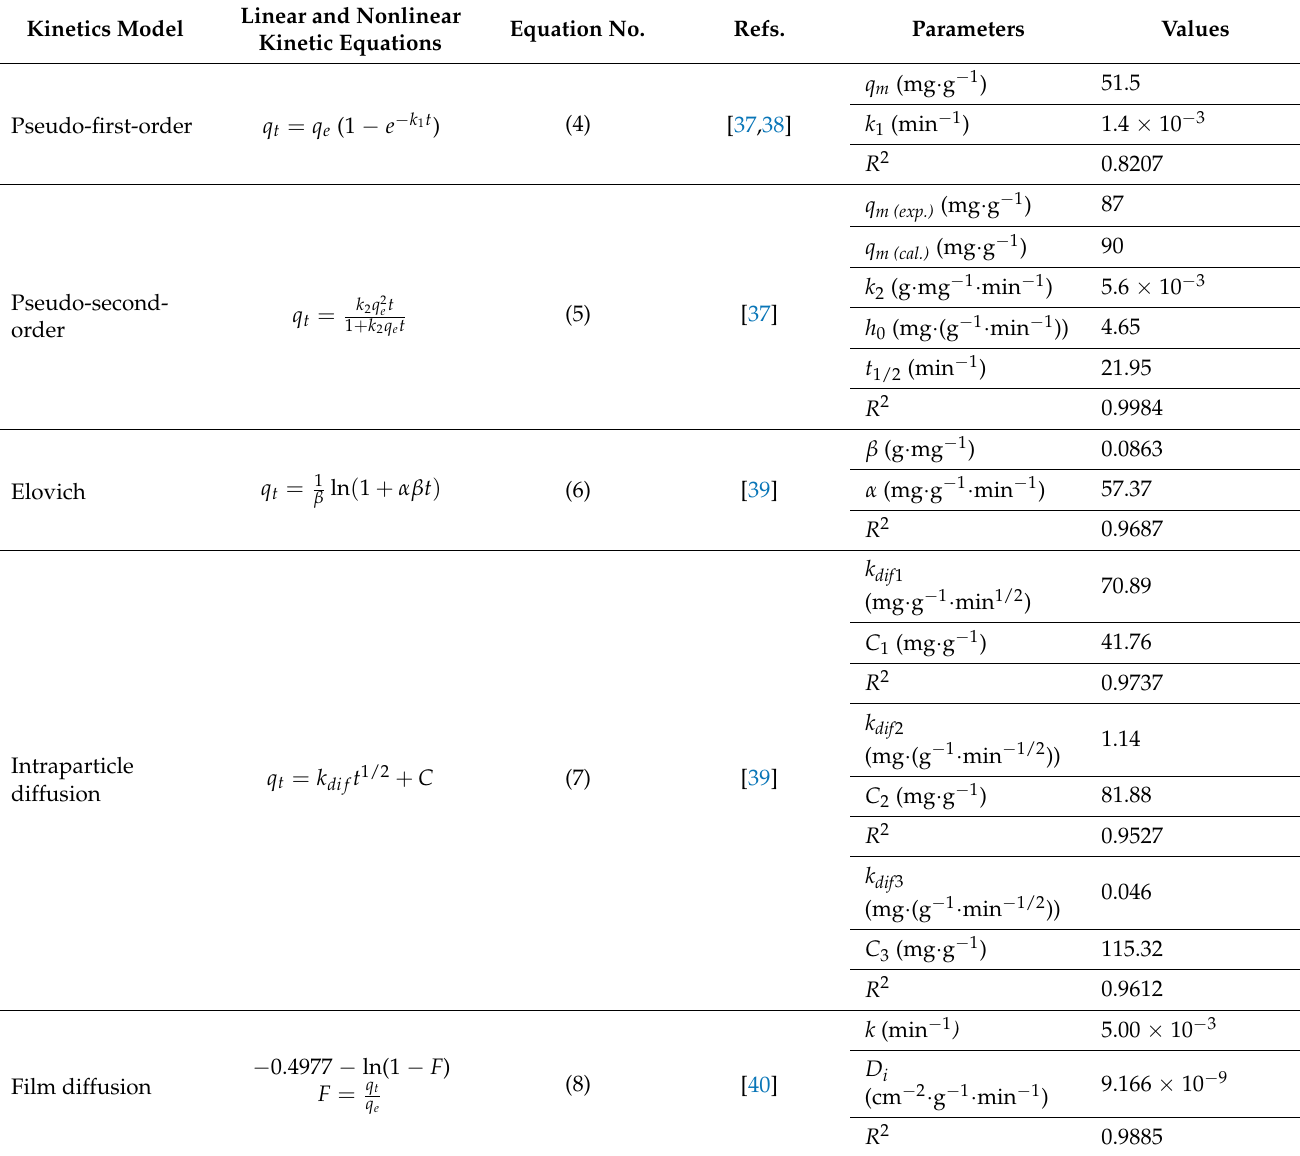
Table 1. Kinetics models’ parameters for the removal of Cu (II) by Zr-G-C 3 N 4 . Linear and Nonlinear Equation No. Refs. Parameters Kinetics Model Kinetic Equations